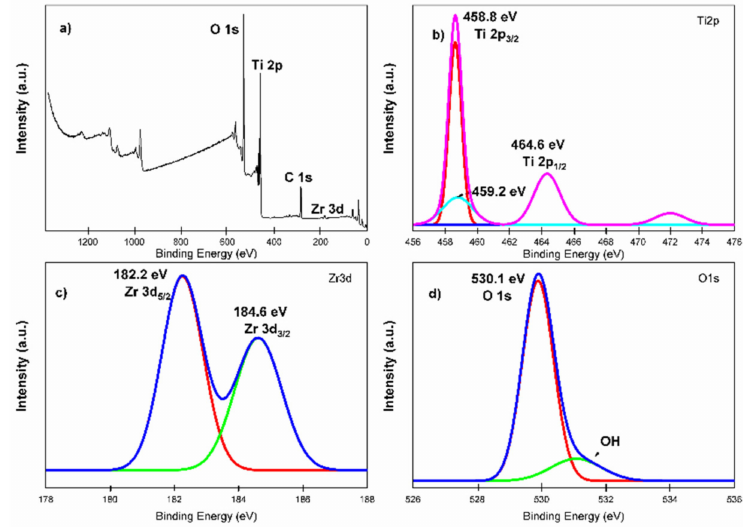
Figure 7. XPS analysis for TZ-1 photocatalyst material. ( a ) Full survey spectra, ( b ) expanded spectra of Ti2p, ( c ) expanded spectra of Zr3d and ( d ) expanded spectra of